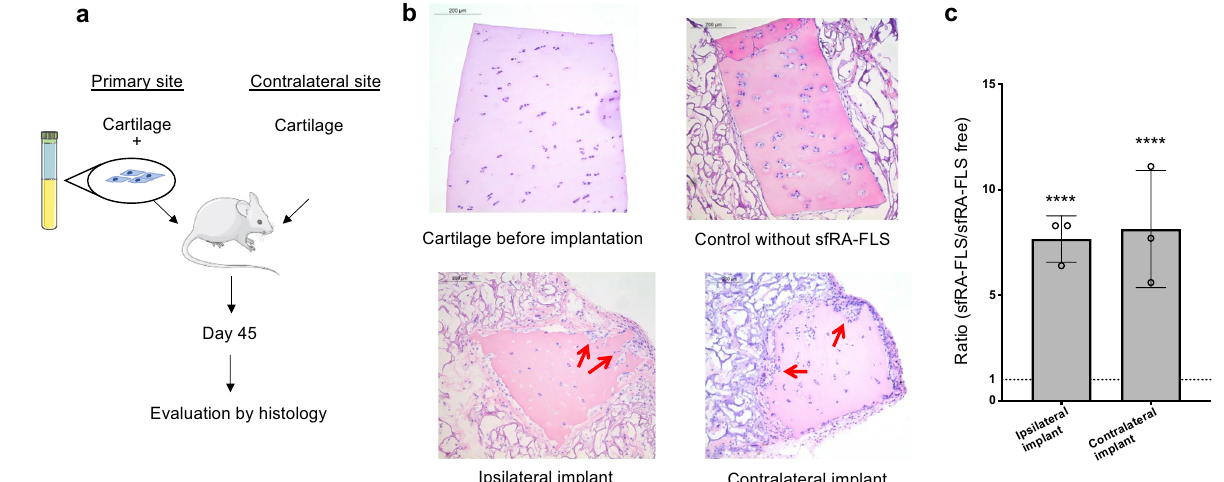
Figure 3. sfRA-FLS are cartilage invasive and have abilities to migrate to unaffected joints. Cartilage invasion of sfRA-FLS at primary implant and at contralateral implant in SCID mice after 45 days. ( a ) Cartilage and sfRA-FLS were co-implanted at primary site into SCID mice and cartilage without sfRA-FLS were implanted at contralateral site. Results were compared to SCID mice with only cartilage implants at ipsilateral and contralateral site (sfRA-FLS free). Cartilage invasion score were evaluated at day 45. 0 = no invasion, 3 = more than 10 cell depths invasion. sfRA-FLS were isolated and cultured from RA donors (n = 3) and repeated with 5 mice (n = (6 groups × 5 animals) 30). ( b ) Representative histology showing cartilage invasion (red arrows) in both ipsilateral implant and contralateral implant. ( c ) Ratio describing sfRA-FLS invasion in ipsilateral and contralateral implants normalized to sfRA-FLS free SCID mice. Data is represented as median with interquartile range, **** p ≤ 0.0001. Figures were generated with images from Servier Medical Art (www. servi er. com), licensed under the Creative Commons Attribution 3.0 Unported License (http:// creat iveco mmons. org/ licen se/ by/3. 0/).